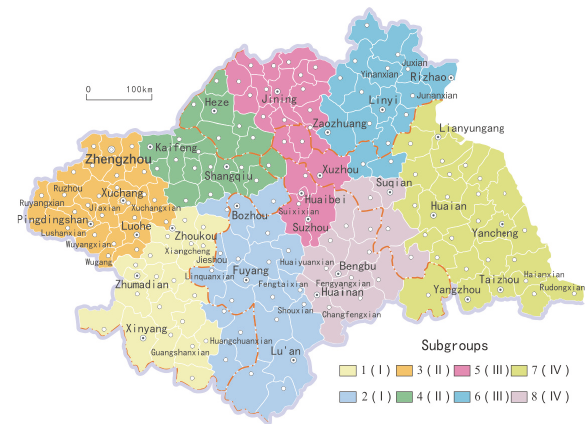
Figure 6: The distribution of subgroups of the HRB in 2014.